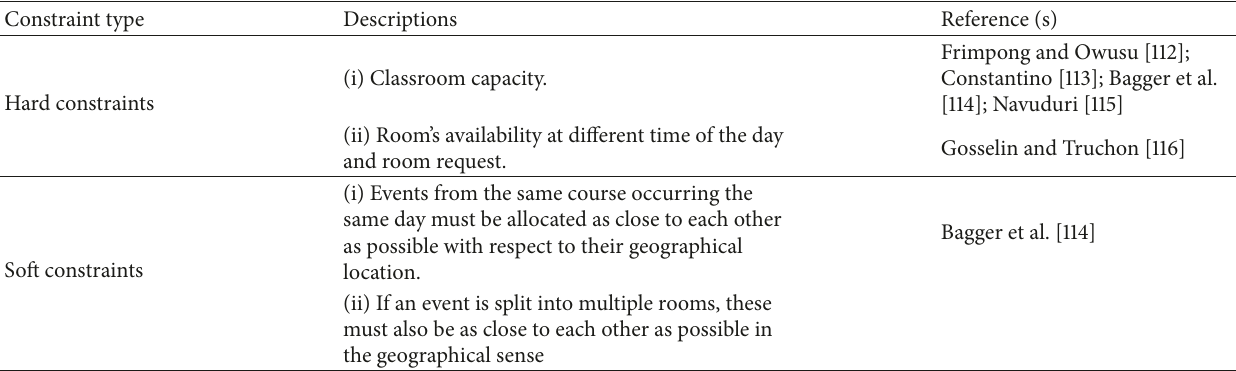
Table 16: The hard and soft constraints within the SAP.